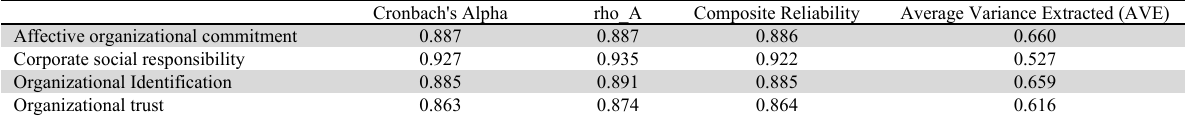
Construct Reliability and Validity